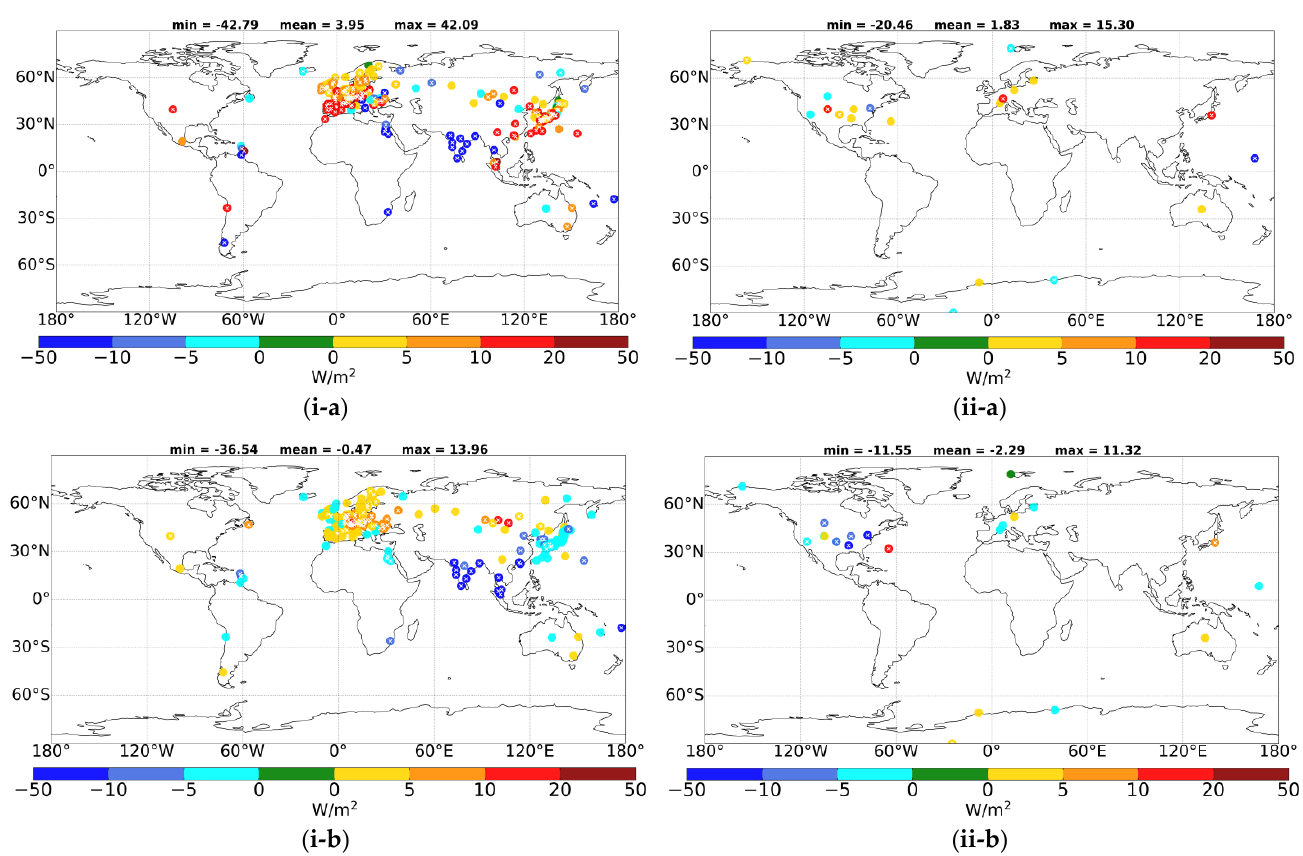
Figure 8. Computed GDB (or Δ (SSR), in W/m 2 ) for GEBA ( i-a ) and BSRN ( ii-a ) stations and for the corresponding pixels of MERRA-2 containing the GEBA ( i-b ) and BSRN ( ii-b ) stations. Negative values, shown in blue and green colors, indicate dimming, and positive values, orange and red colors, indicate brightening. The embedded white x symbols indicate trends which are statistically significant (assessed at the 95% confidence level by applying the non-parametric Mann Kendall test). The trends are estimated over the periods covered by each station (shown in Figure S2).